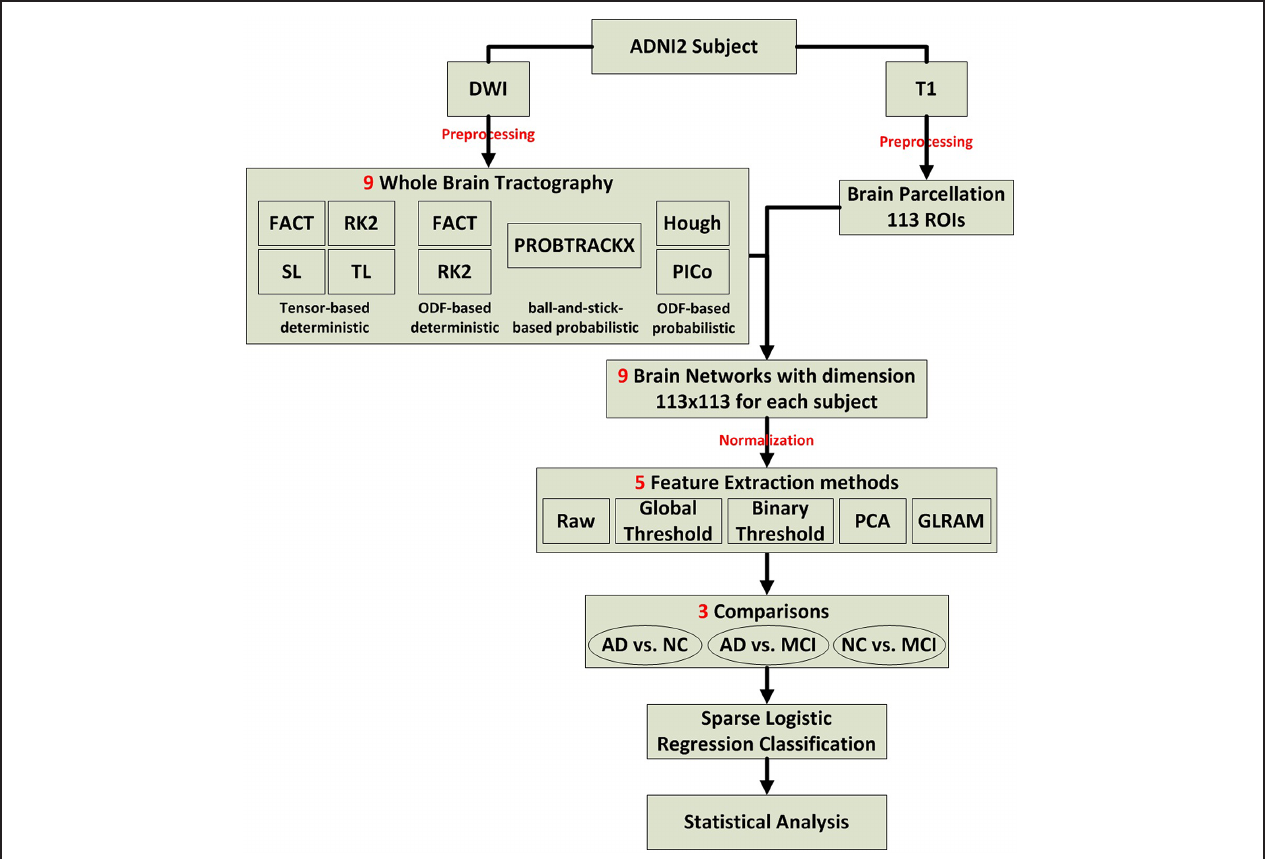
FIGURE 1 | Flow chart describing the steps taken in this study to create, analyze, and compare structural